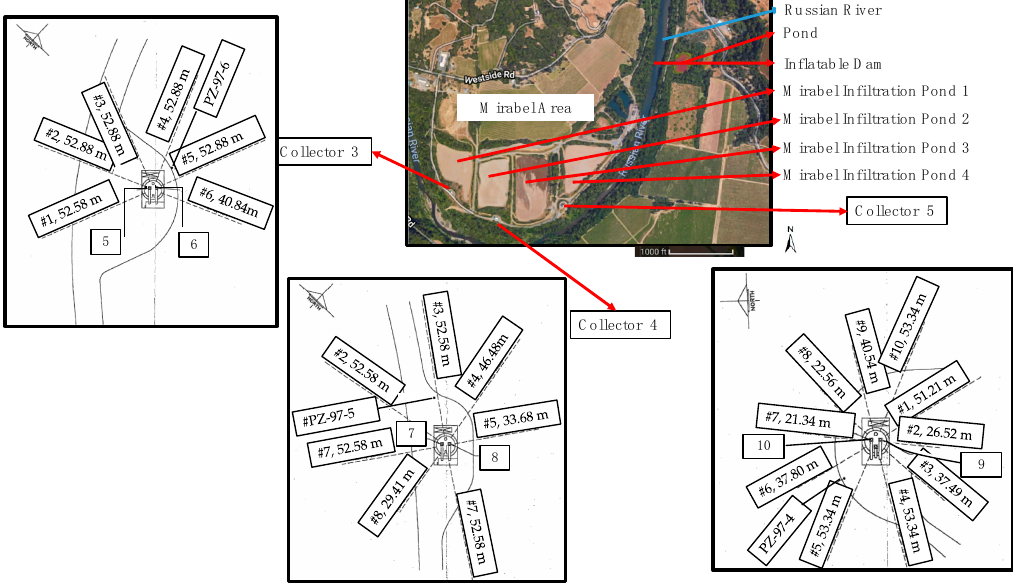
Figure 2. Mirabel Area, Sonoma County Water Agency, Sonoma County, California. Modified from [3]. The alluvium along the Russian River is the primary source of water production for